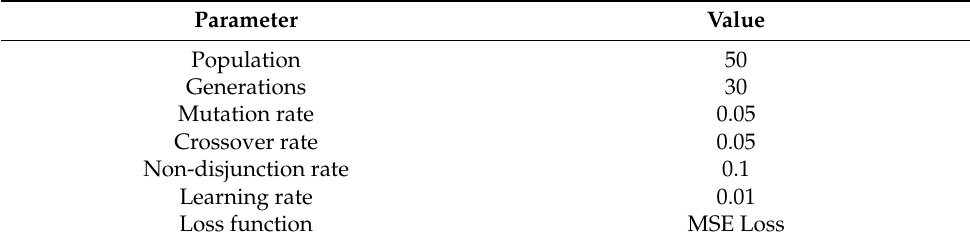
Table 3. Parameters of Experiment.